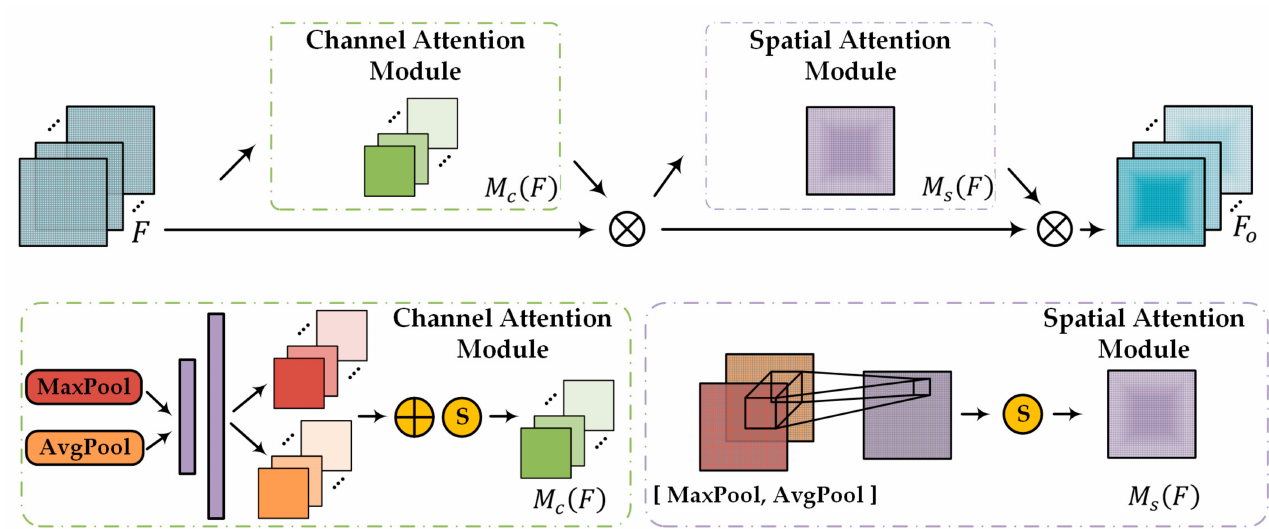
Figure 11. Architecture of